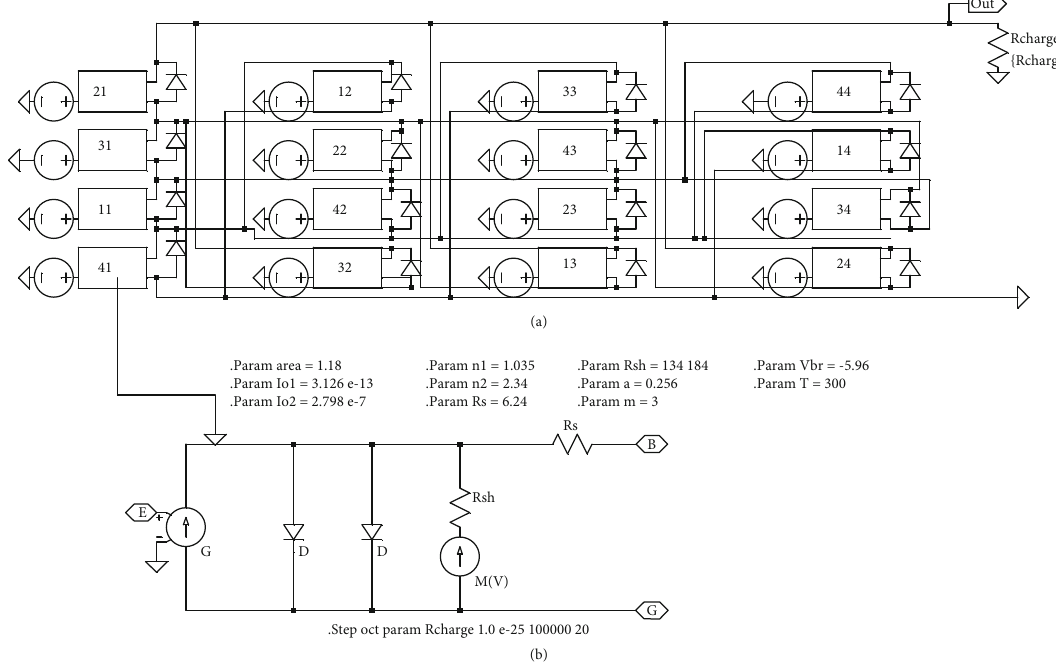
Figure 10: Circuit of the PV module used in LTSpice software: (a) PV module model and (b) PV cell model.